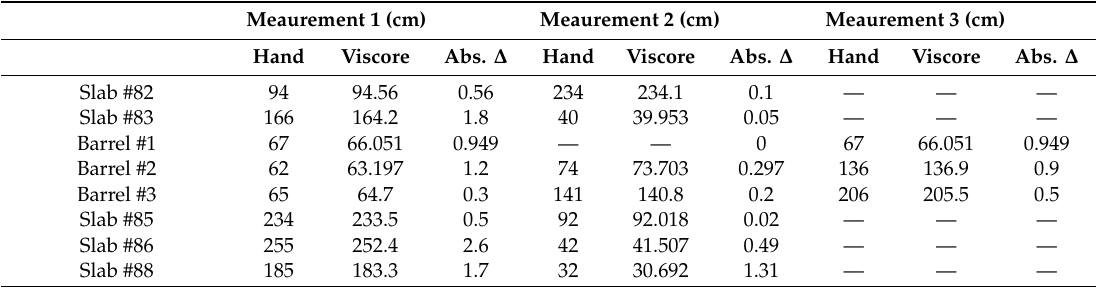
Table 2. Artifact hand measurements and artifact SfM model